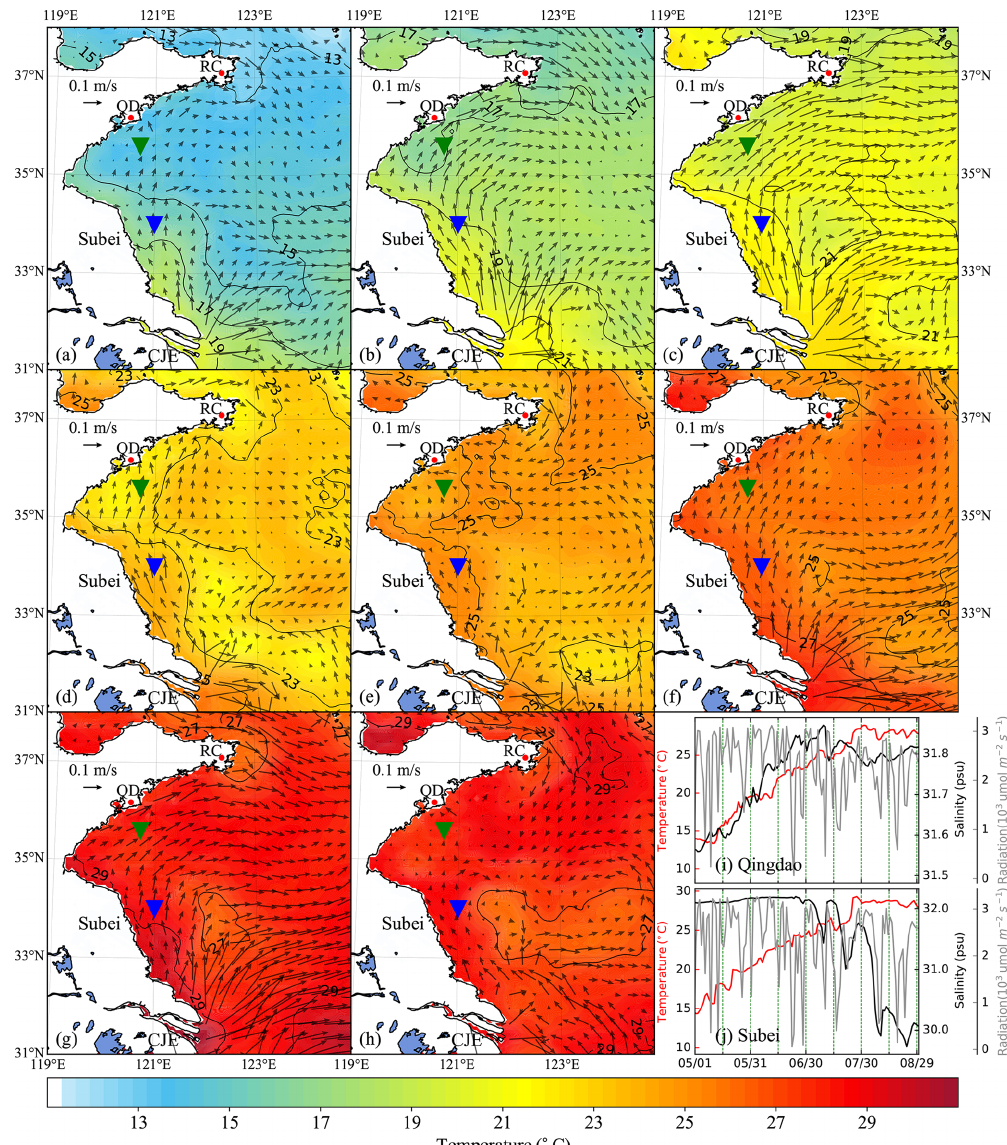
Figure 6. Time-averaged distribution of surface current and temperature of every 15d duration in 2015: (a) 1–15 May, (b) 16–30 May, (c) 31 May–14 June, (d) 15–29 June, (e) 30 June–14 July, (f) 15–29 July, (g) 30 July–13 August, (h) 14–29 August. The green and blue inverted triangles indicate the position of selected Qingdao (QD) coast and Subei offshore sites, respectively. Time series of surface temper- ature, salinity, and irradiation in Qingdao (i) and Subei (j)